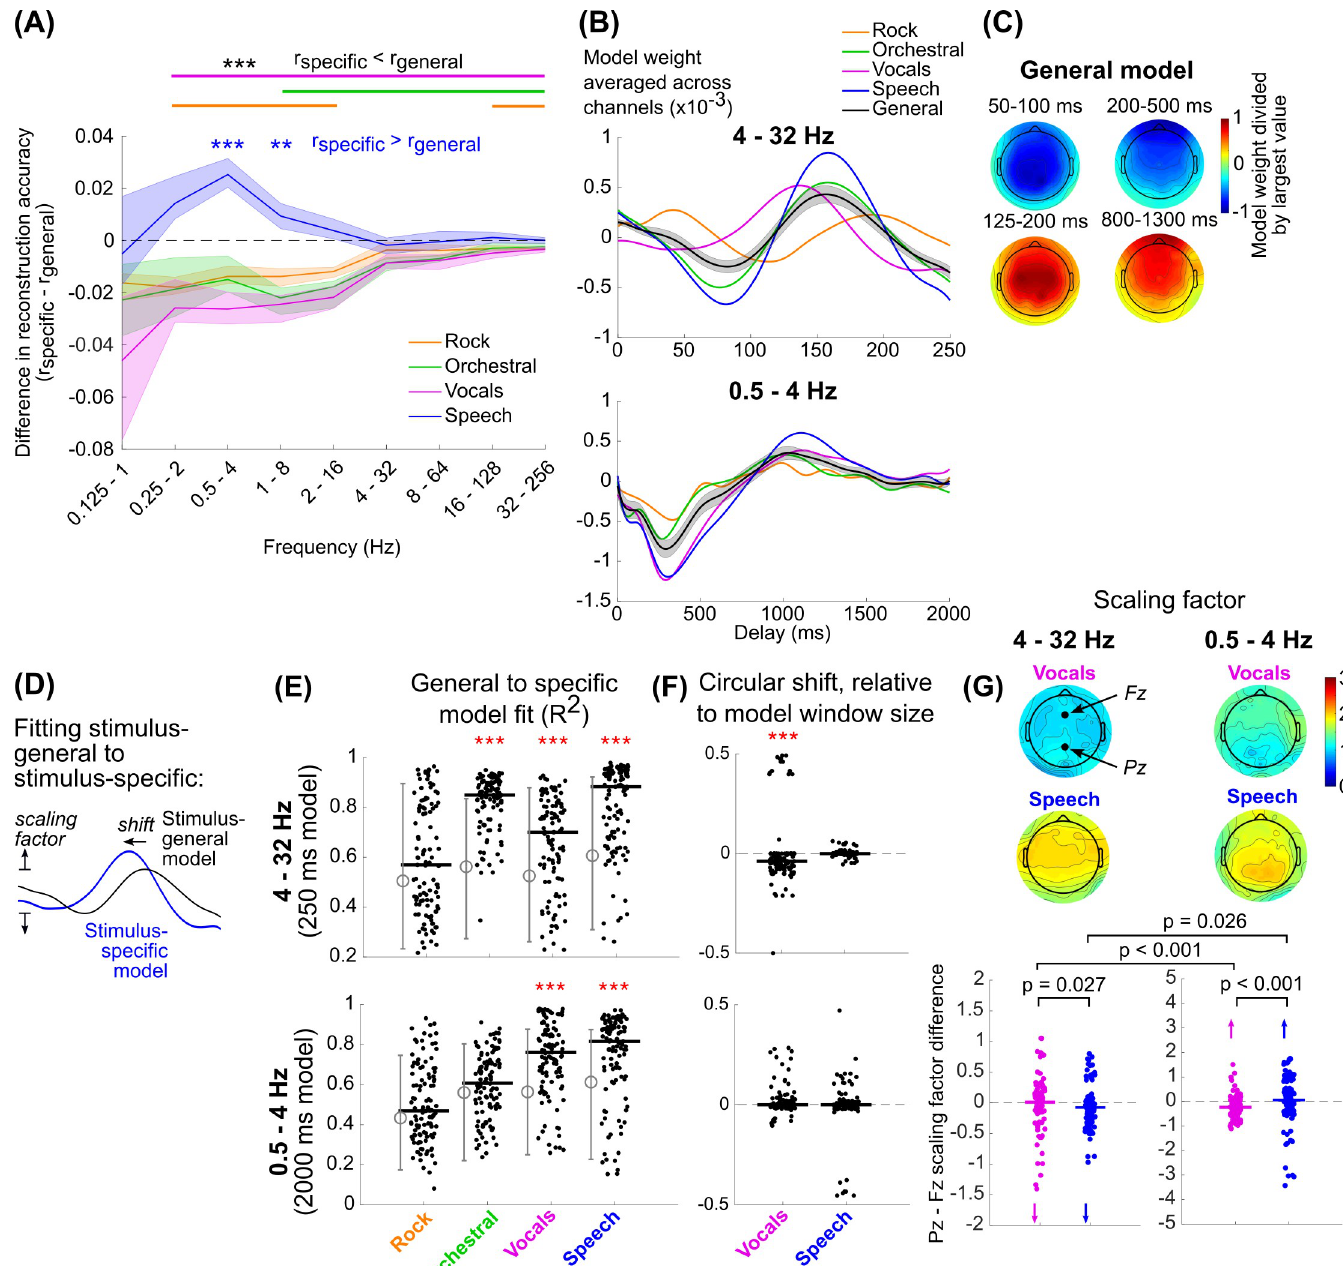
Fig 5. (A) The difference between the trial-by-trial reconstruction accuracies using the stimulus-specific and stimulus-general models was then computed. Lines show the median reconstruction accuracy differences across subjects and trials. Shaded regions show the 95-percentile range of bootstrapped resampled median values. Significance values are based on a Wilcoxon signed-rank test with Bonferroni correction for 32 comparisons, ��� p < 0.001, �� p < 0.01). The stimulus-specific speech model outperformed the stimulus-general model at 0.5–4 Hz and 1–8 Hz (blue text), while the other stimulus-specific models performed worse than the stimulus- general model for most frequency ranges (black text, solid lines at top). (B, C) The stimulus-general model was quite similar in its temporal (B) and spatial (C) pattern compared to the stimulus-specific models. (D) We assumed that stimulus-general model is a scaled and phase shifted version of each of the stimulus-specific models, so by circularly shifting and scaling the model we could quantify the difference between the model weights. The scaling was computed separately for each EEG channel, but we assumed the shift would be identical for all EEG channels. (E) R 2 fits of the scaled and shifted stimulus-general model to each stimulus-specific model on a trial-by- trial basis, based on the summed errors across all EEG channels. Solid black lines show the median values across all trials and subjects. The grey lines to the left of each set of black dots designates the 5% and 95% range of the chance R 2 distribution. Red asterisks show the stimulus-types for which the fits were significantly better than chance (Wilcoxon rank-sum, p < 0.001). (F) Distribution of circular shifts plotted identically to E. Red asterisks show distributions whose medians are significantly different than zero (Wilcoxon signed-rank, p < 0.001). (G) Above, topography of scaling factors for vocals and speech. The scaling factors at channels Fz and Pz were